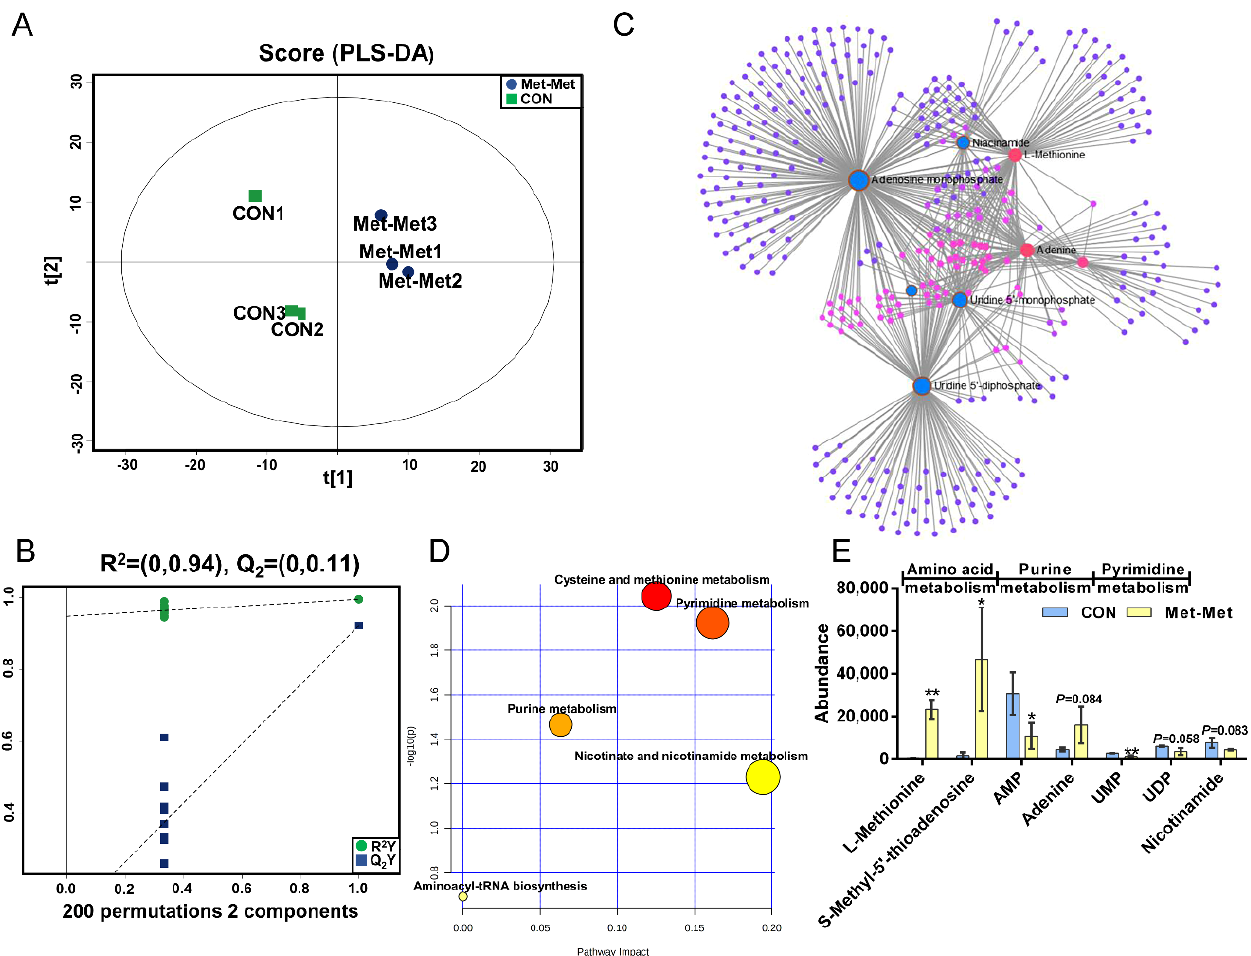
Figure 2. The MAC-T cell metabolomics profile is affected by Met-Met. ( A ). The PLS-DA score plot of the Met-Met vs. CON group. ( B ). Cross-validation plot of the PLS-DA model with 200 permutation tests in the Met-Met vs. CON group. ( C ). Metabolite-metabolite interaction network of DMs in the Met-Met vs. CON group. Node size represents the degree. Red and blue circles correspond to the increased and reduced DMs in the Met-Met vs. CON group, respectively. ( D ). Pathway analysis of DMs in the Met-Met vs. CON group. The X -axis represents the pathway impact, and the Y -axis represents the pathway enrichment degree. A darker color indicates a higher degree of pathway enrichment, and a larger size indicates a higher pathway impact value. ( E ). The classification map of DMs. * p < 0.05, ** p < 0.01, when compared the Met-Met with the CON group; DMs: differential metabolites.